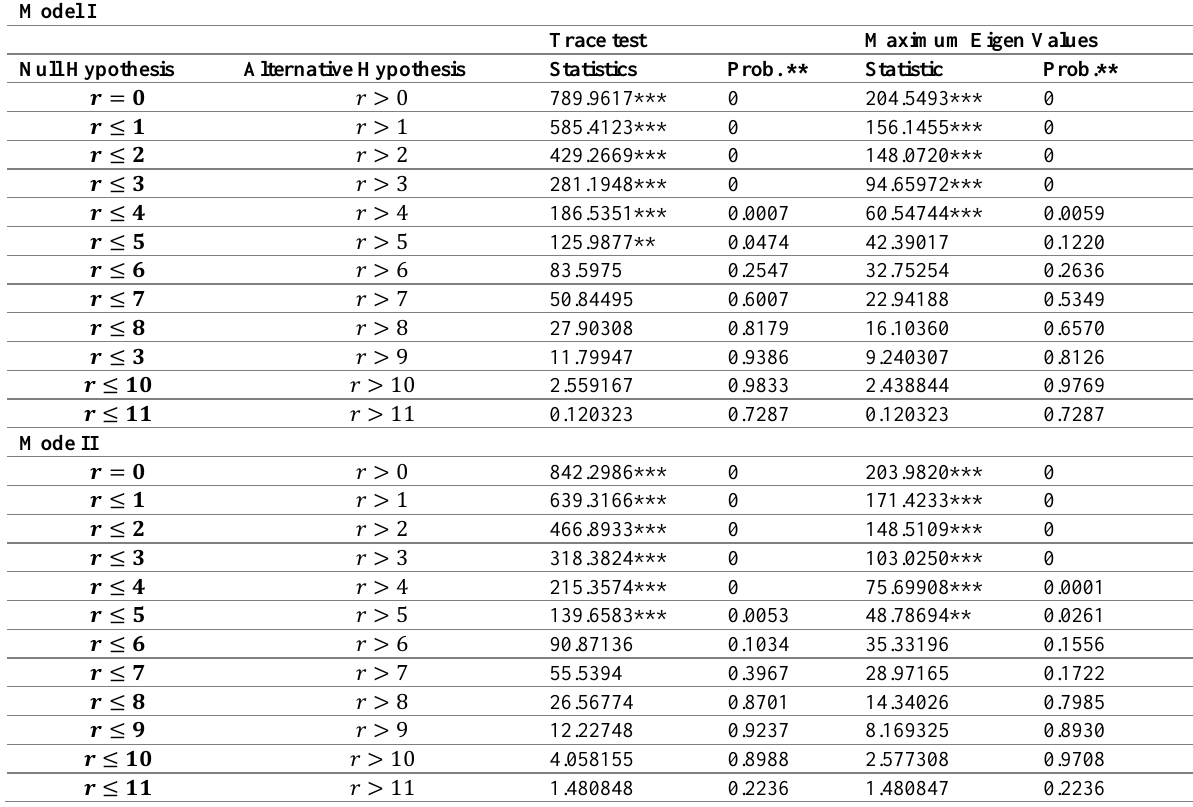
Table 5: Cointegration